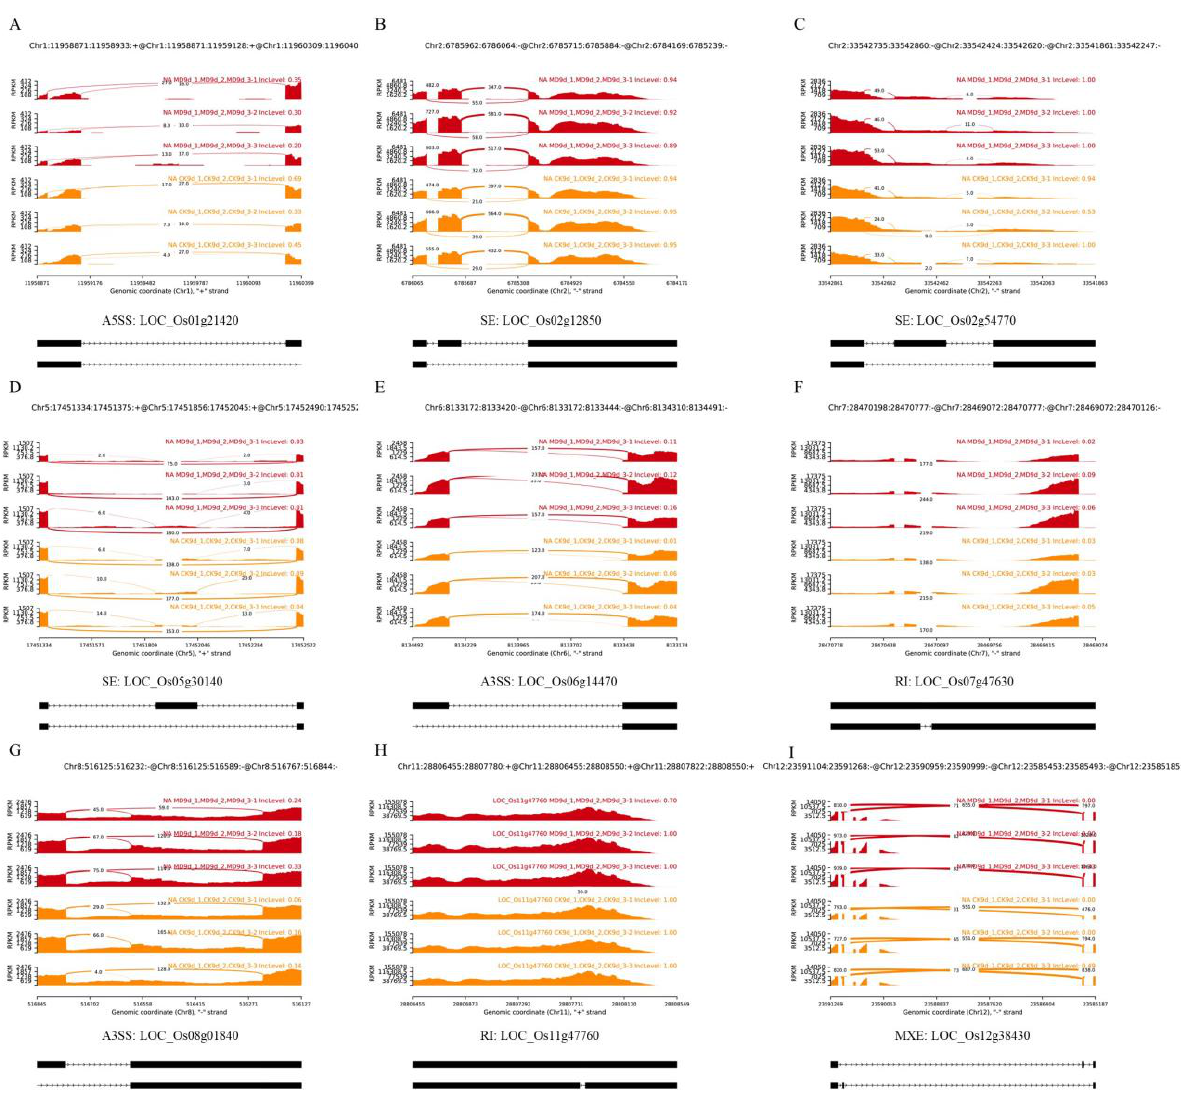
Figure 3. Quantitative visualization (Sashimi plot) of some DAS events of spliceosome pathway genes of rice inferior spikelets in the comparison of CK and MD at 9 DAA. ( A ) LOC_01g21420; ( B ) LOC_02g12850; ( C ) LOC_02g54770; ( D ) LOC_05g30140; ( E ) LOC_06g14470; ( F ) LOC_07g47630; ( G ) LOC_08g01840; ( H ) LOC_11g47760; ( I ) LOC_12g38430. Each track visualizes the splicing event within the biological replicates for the CK (orange) and MD (red) treatment samples. Count values on curved lines describe the coverage within the splice junction. The left scale presents the coverage depth in the range of the AS region. IncLevel are presented on the right side for each track. AS models are indicated below the figure.